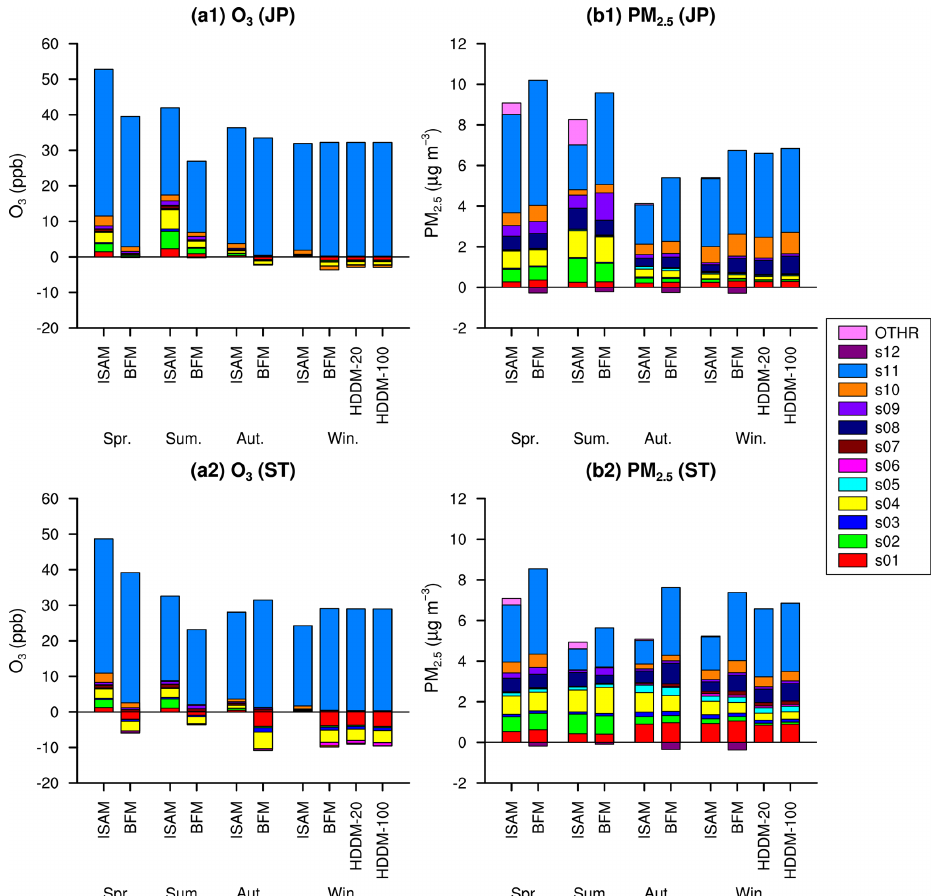
Figure 6. Apportionments derived by ISAM and sensitivities derived by BFM and HDDM of the simulated ozone and PM 2 . 5 concentrations to all source groups in JP and ST for the 2 target weeks in the four